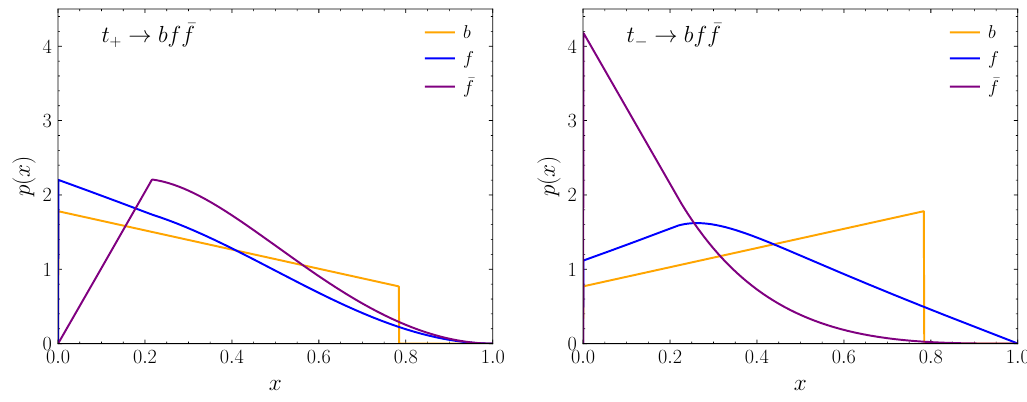
Figure 7 . The distribution of energy fractions carried by polarized top-decay products, as described by eq. (C.16) and (C.23). Here f ¯ f represent the particle and antiparticle that result from the decay of the intermediate on-shell W